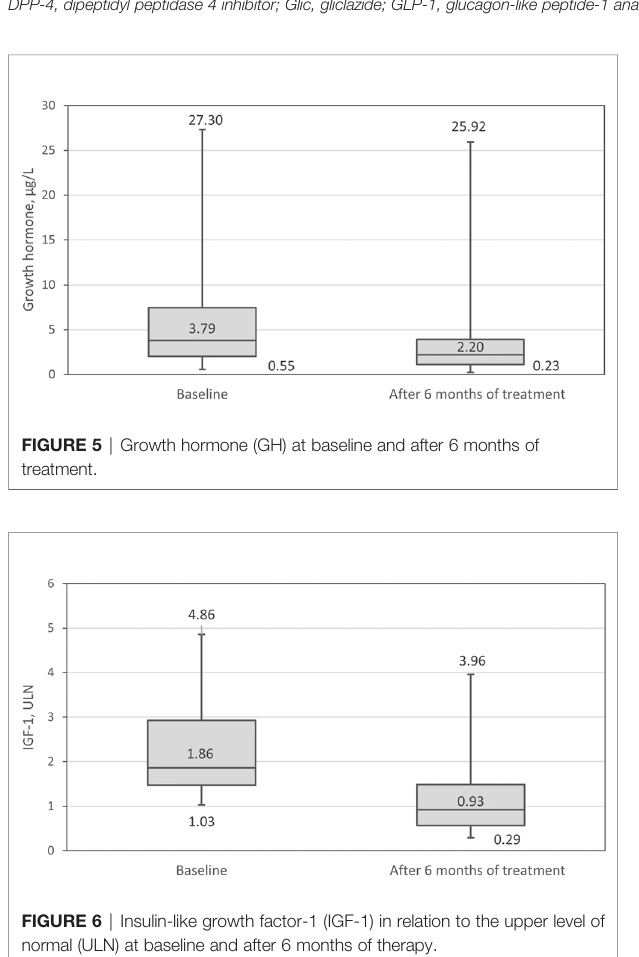
FIGURE 6 | Insulin-like growth factor-1 (IGF-1) in relation to the upper level of normal (ULN) at baseline and after 6 months of